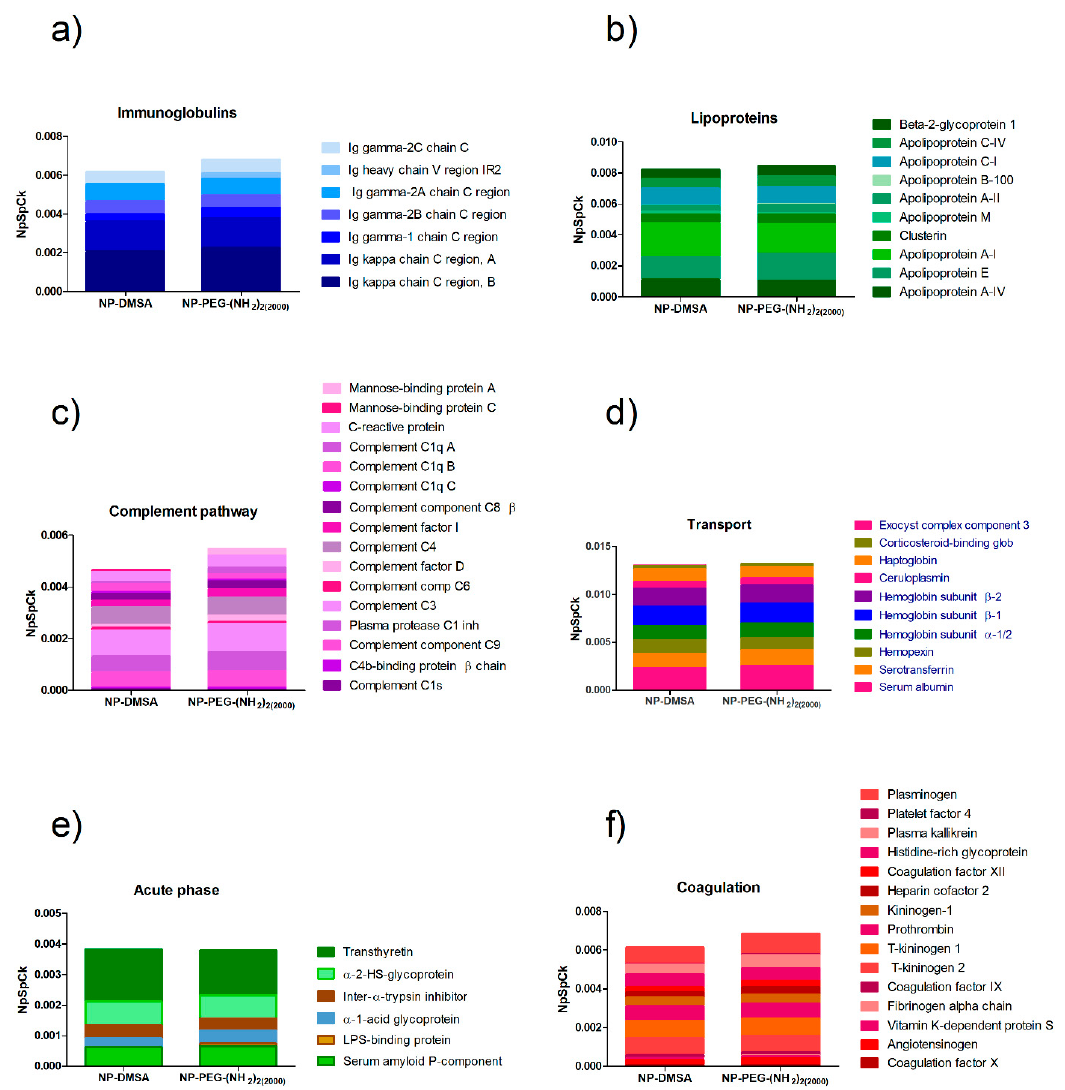
Figure 5. Semiquantitative analysis of the protein corona composition of NP-DMSA and NP-PEG-(NH 2 ) 2(2000) . ( a ) Inmunoglobulins; ( b ) Lipoproteins; ( c ) Complement pathway; ( d ) Transport; ( e ) Acute phase; ( f ) Coagulation.